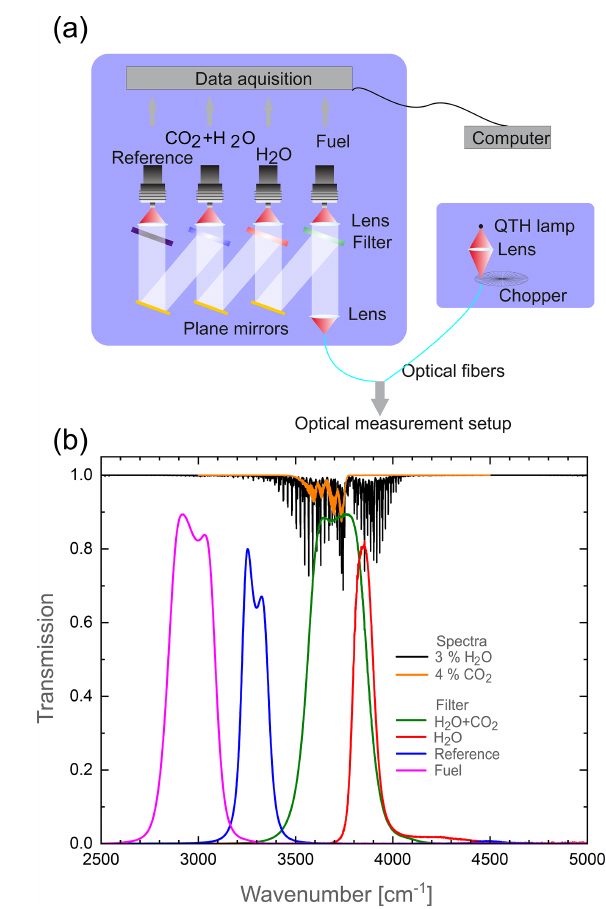
Figure 5. (a) Schematic of the ICOS sensor system consisting of different measurement channels. (b) Transmission spectra of the bandpass filters used in the ICOS sensor system as well as the spec- tra for H 2 O and CO 2 . Note that the serial assembly causes the band- pass filter, influencing each